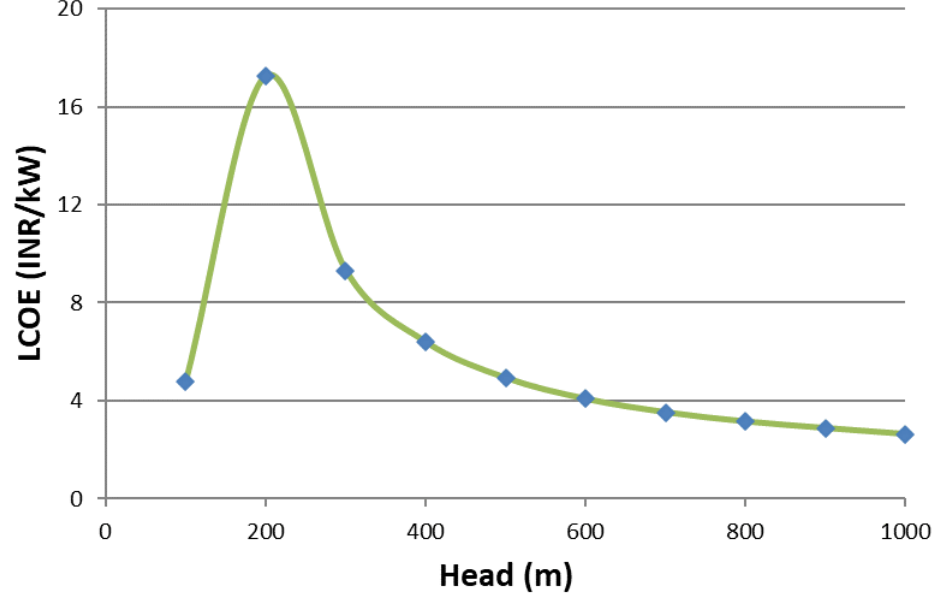
Figure 7. Variation of LCOE w.r.t head for 2000 kW high head SHP schemes.